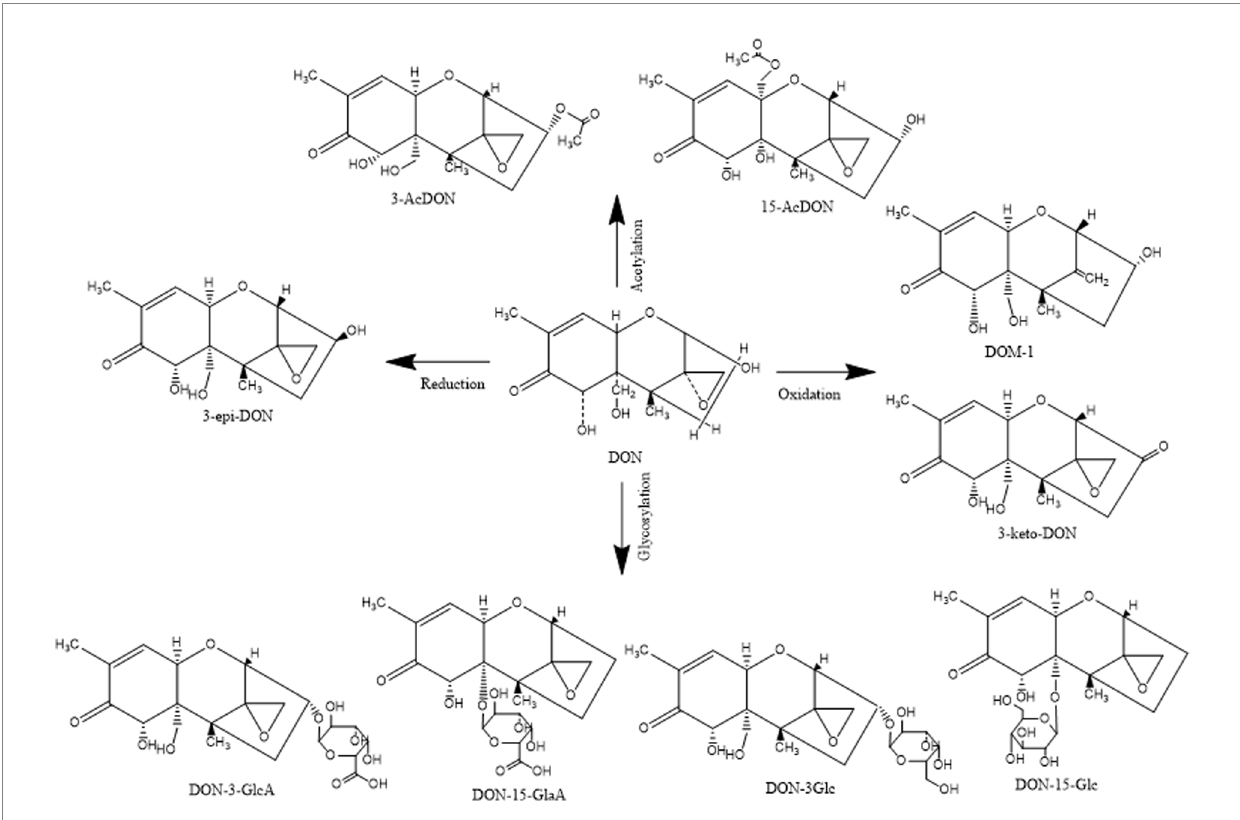
FIGURE 2 Structural formula of DON and its